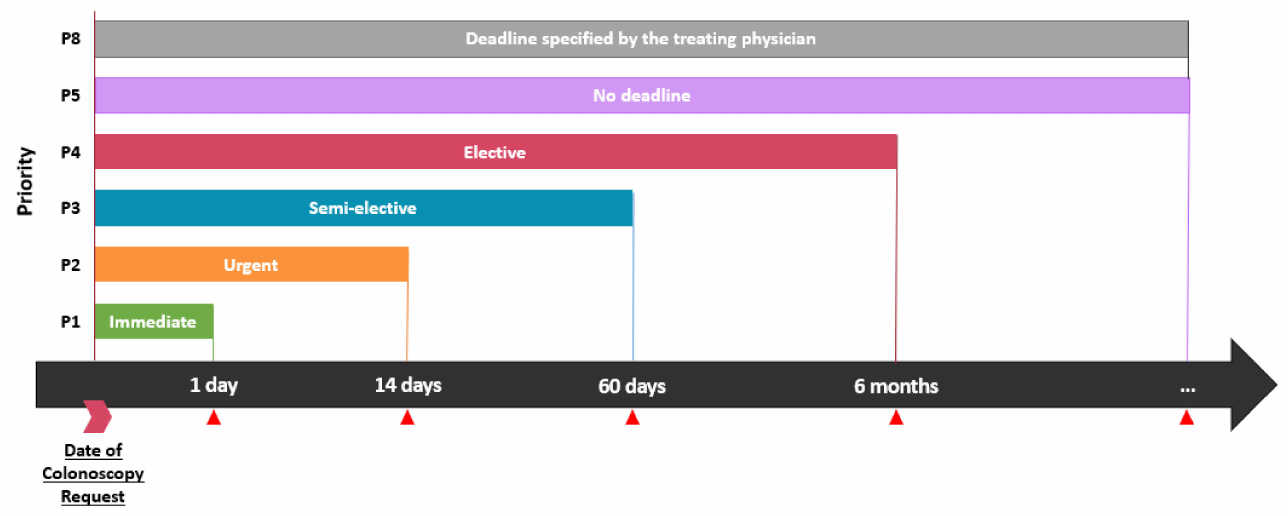
Figure 1. Ministry of Health and Social Services (MSSS) grading system for elective colonoscopy in Quebec,